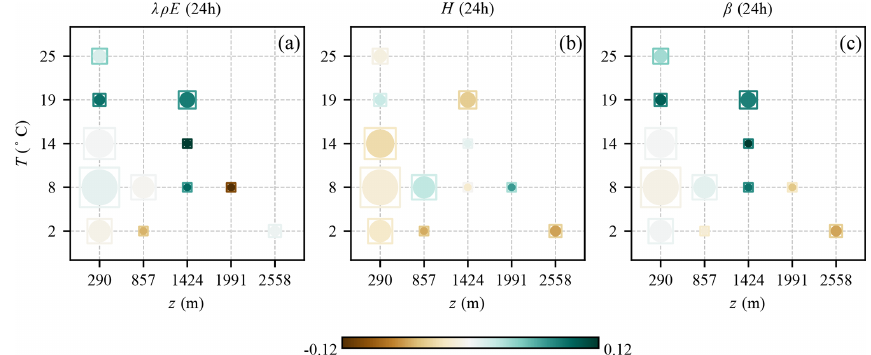
Figure 17. Standardized anomaly correlation difference (circles) and standardized mean absolute differences (squares) between ERA5-Land and ERA5 latent heat flux (a) , sensible heat flux (b) , and Bowen ratio (c) , grouped as a function of stations temperature and altitude. The size of circles and squares is proportional to the number of eddy-covariance towers. Green values denote better matching of ERA5-Land with in situ data.